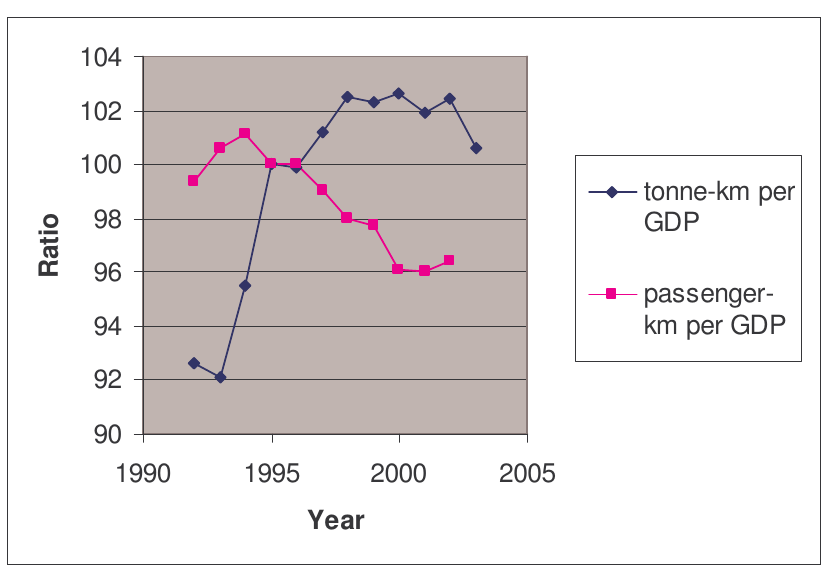
Figure 4. Ratios of freight 6 and passenger 7 transport performance to GDP source: